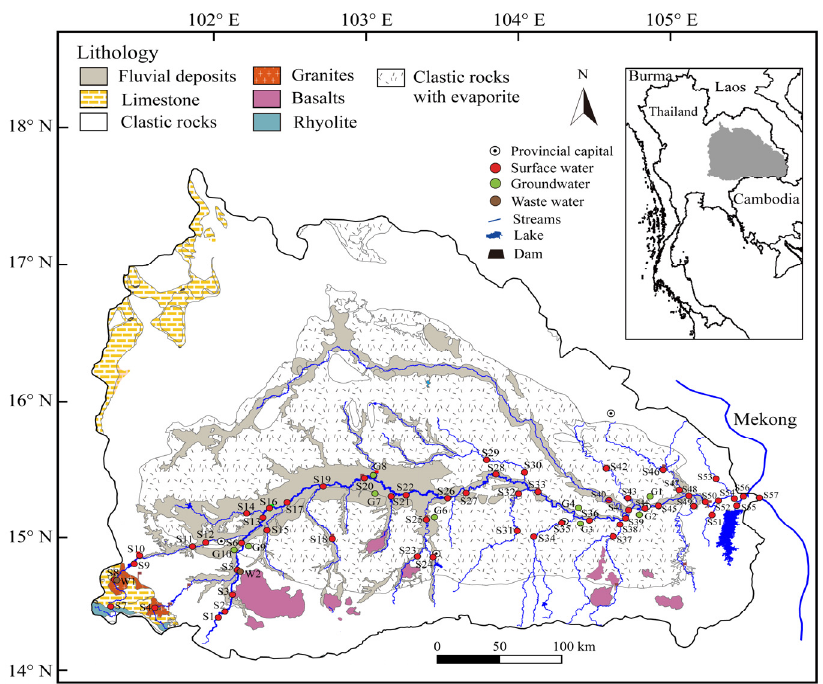
Figure 1. The lithology and sampling sites of the Mun River watershed in Northeast Thailand.